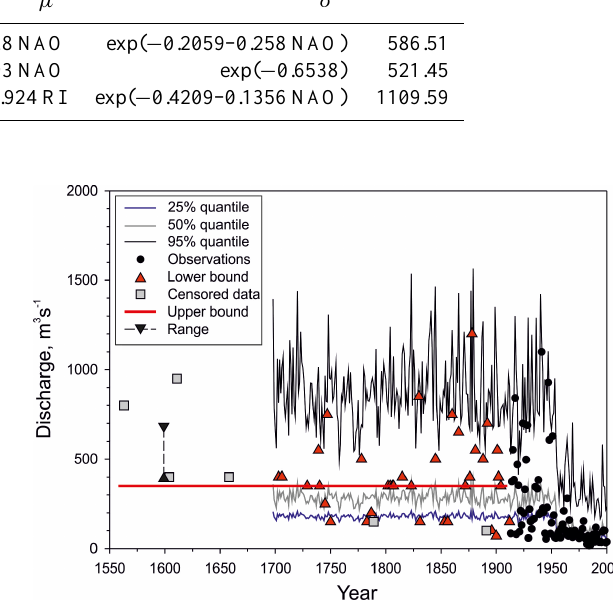
Figure 10. Estimated quantiles for the model using systematic in- formation under a natural regimen (1913–1956) and the systematic information (1913–2008), with the NAO index and reservoir index as the explanatory variables of the distribution